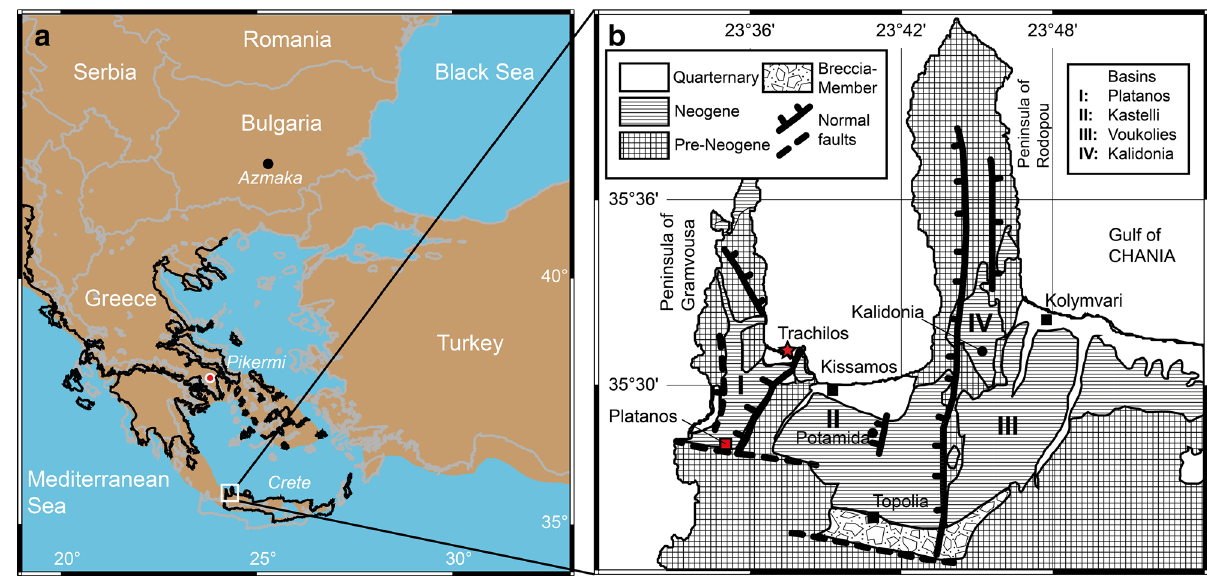
Figure 1. ( a ) Map of the study location on Crete (white square) together with the Aegean Sea. Black coastline, brown land and blue sea surface is based on reconstructions of the area for 6.0 Ma 11 . Circles show the position of the hominid sites of Pyrgos Vassilissis (close to Pikermi) and Azmaka 1 . ( b ) Local geological map of the study area in north-western Crete 8 showing the main deposition basins and the Trachilos section (red star). Maps were created using GMT5 12 (https:// www. gener ic- mappi ng- tools.